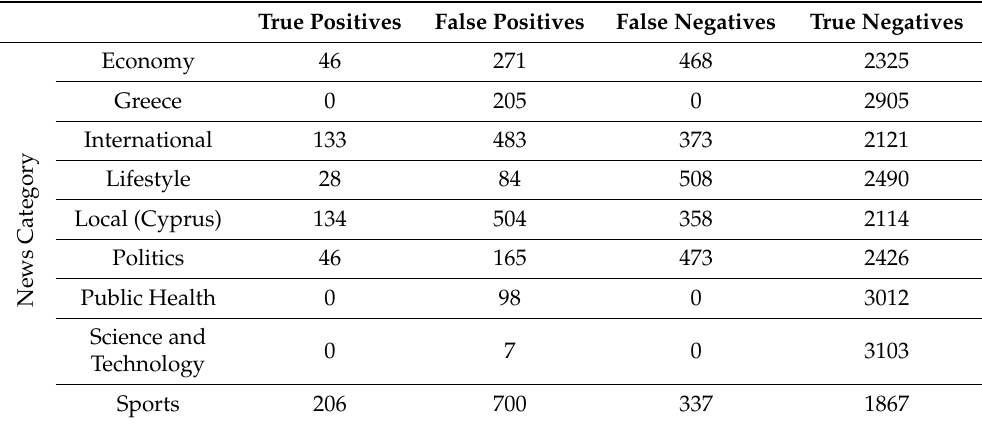
Table 4. Re-composition of Figure 8 into a per-news category confusion